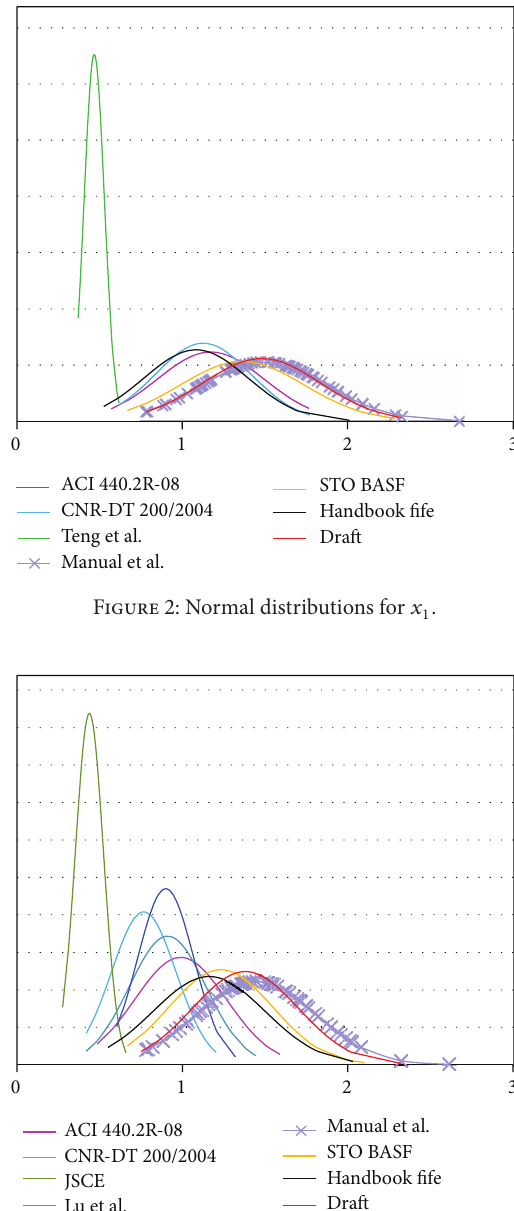
Figure 3: Normal distributions for 𝑥 2 .